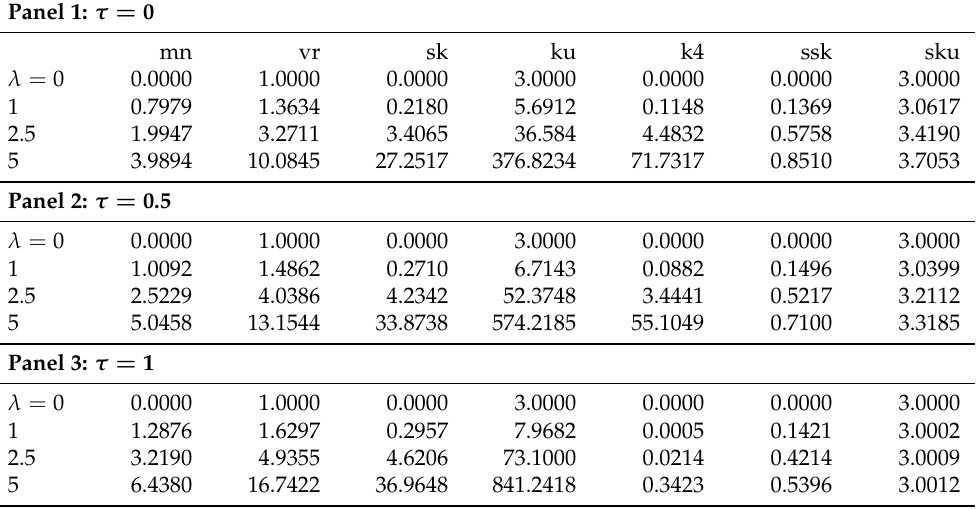
Table 4. Moments of the extended skew-normal distributions τ ≥